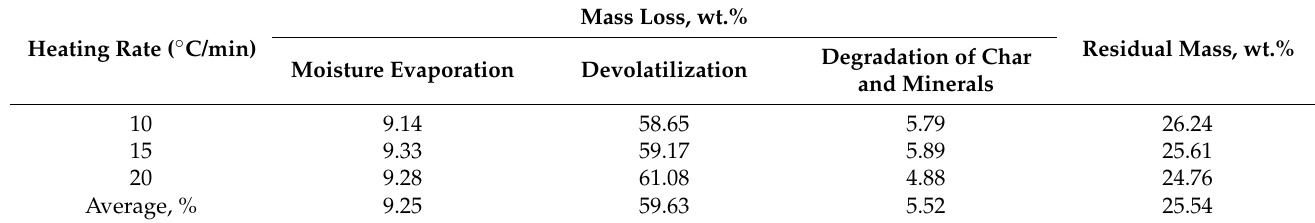
Table 6. Mass loss characteristics of AIW obtained from TGA